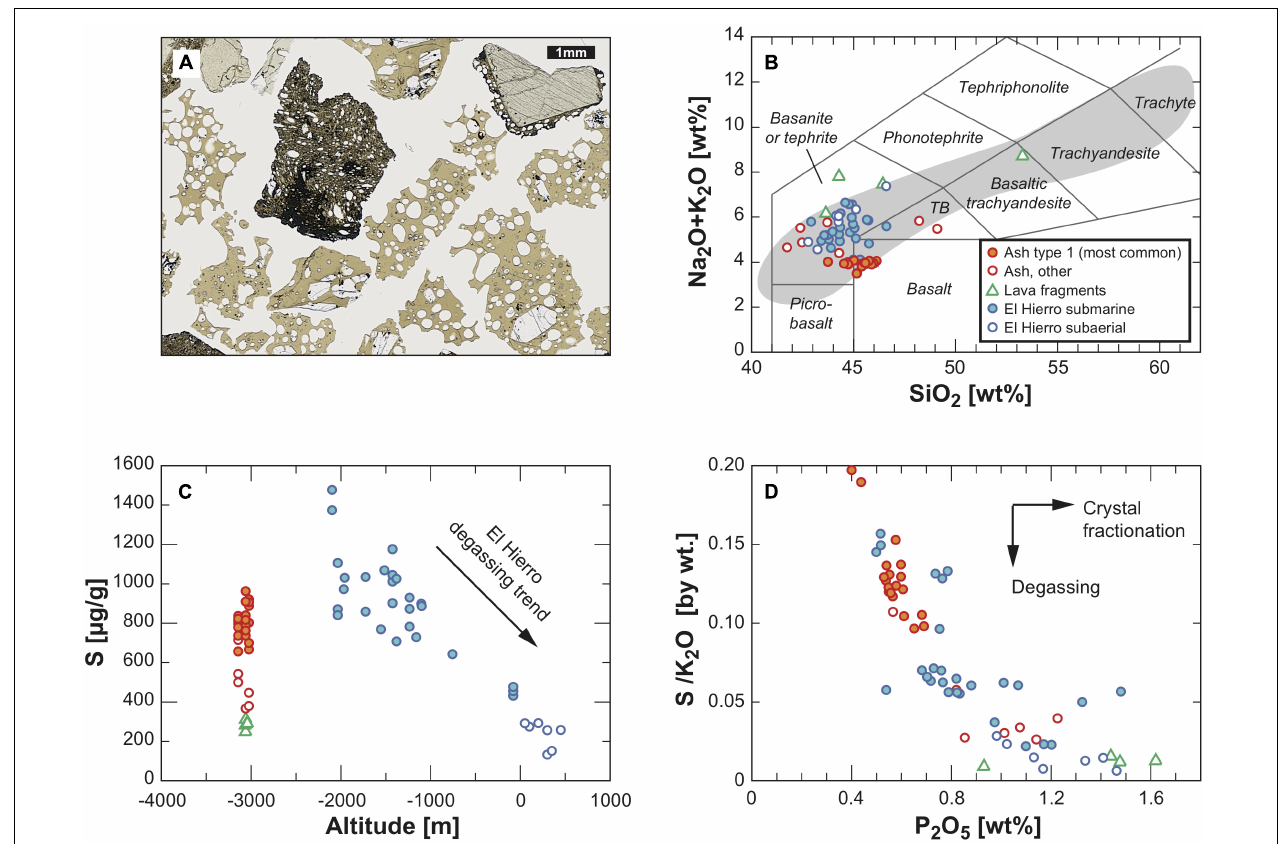
FIGURE 3 | (A) Microphotograph of glassy basaltic ash (sample 22841-1A, > 0.5 mm sieve fraction) from Henry Seamount; note the lack of palagonitization and small vesicle diameters. Type 1 ash is dominated by fresh glass with olivine phenocrysts and few microlites. (B) Total alkalis versus silica (TAS) diagram of matrix and interstitial glasses from Henry Seamount samples, compared to matrix glasses from submarine samples (Stroncik et al., 2009; Longpré et al., 2014) and subaerial samples (this study) from El Hierro. The compositions overlap with those of whole-rock samples from El Hierro (gray field based on data from Pellicer, 1979; Carracedo et al., 2001; Stroncik et al., 2009; Day et al., 2010; Klügel et al., 2011). (C) Sulfur contents of matrix and interstitial glasses from Henry Seamount and from submarine and subaerial El Hierro samples (including data from Stroncik et al., 2009). The good correlation between sample altitude and S content of the El Hierro glasses indicates strong pressure control on sulfur degassing. (D) The S/K 2 O versus P 2 O 5 diagram shows that type 1 ash includes the least degassed samples, and that degassing is accompanied by crystal fractionation (Wallace and Edmonds,